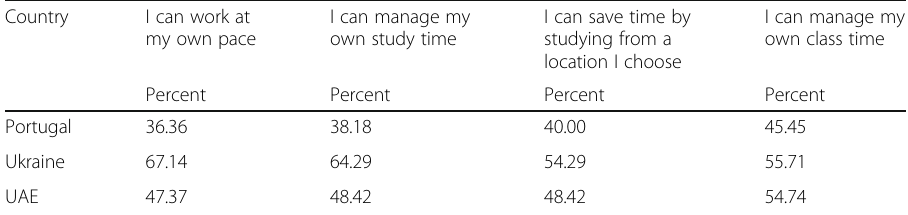
Table 4 Reasons to enroll in distance education courses (More than one could be chosen) Country